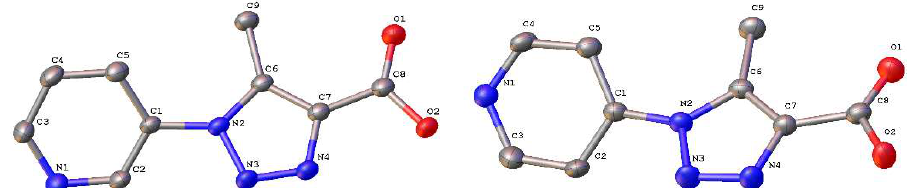
Figure 1. ORTEP plot for compounds L1H ( left ) and L2H ( right ). Hydrogen atoms were omitted for clarity’s sake. Thermal ellipsoids were drawn with 30% of probability.